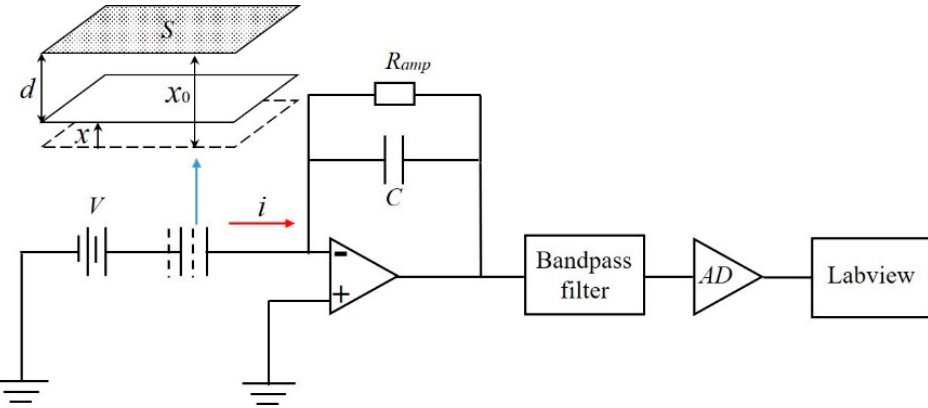
Figure 4. The schematic of the electrostatic detection.